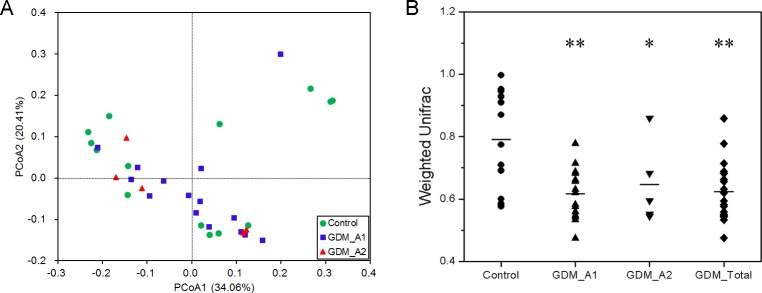
The beta-diversity of the microbial communities in the control and GDM groups.(A) Principal Coordinates Analysis (PCoA) plot based on weighted UniFrac distance. Each dot represents one sample from each group. (B) Beta-diversity index difference based on weighted UniFrac. The P-values were calculated using Wilcoxon test. Statistical significance is displayed as * P < 0.05 and ** P < 0.01.